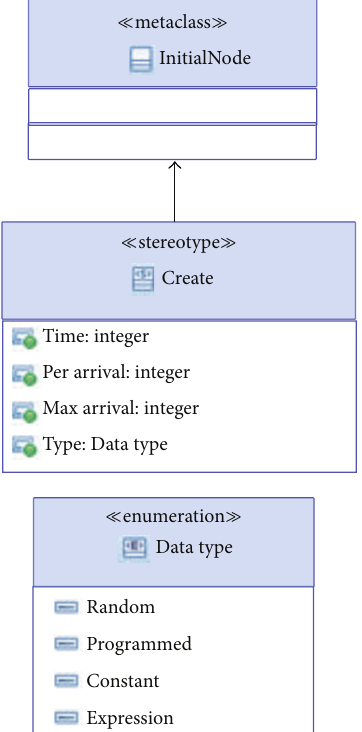
Figure 4: Relationship between metaclass and stereotype ≪ Create ≫ .